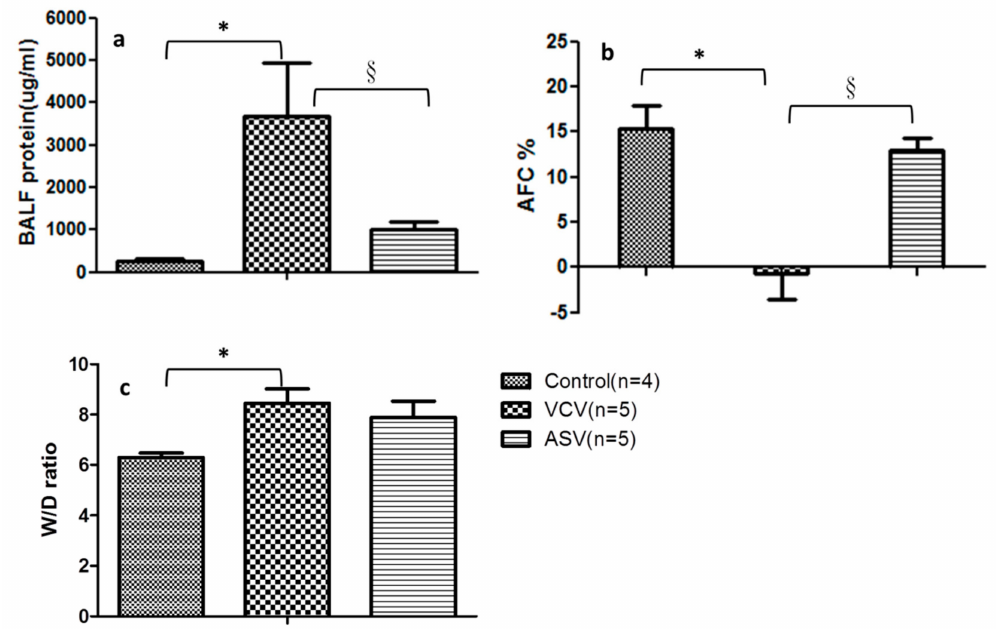
Figure 3. Indicators of lung injury in the experimental groups. ( a ) BALF total protein content, ( b ) alveolar fluid clearance (AFC) rates, and ( c ) the wet-to-dry ratio of lung tissue. * p < 0.05 compared with the control group; § p < 0.05 compared with the VCV